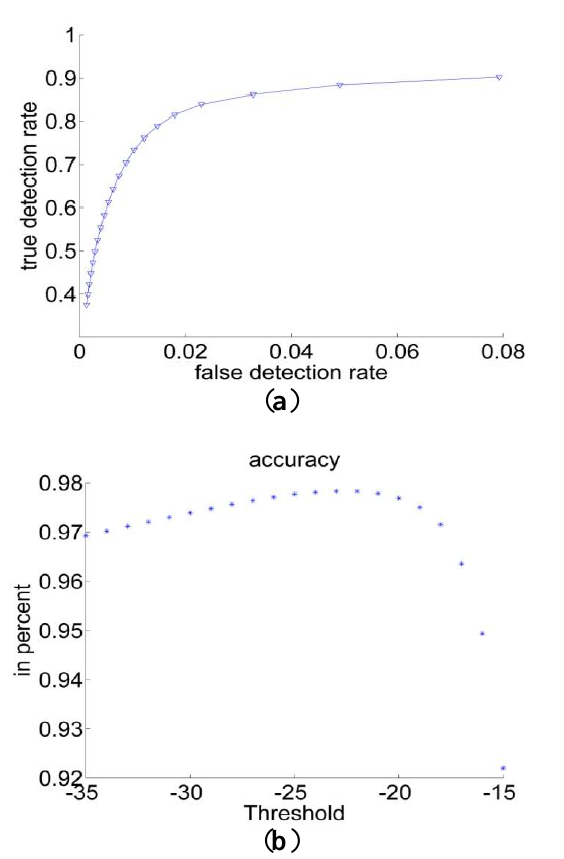
Figure 8. ( a ) ROC curve of RGB space for the threshold classifier; ( b ) Accuracy measurements of the threshold classifier.